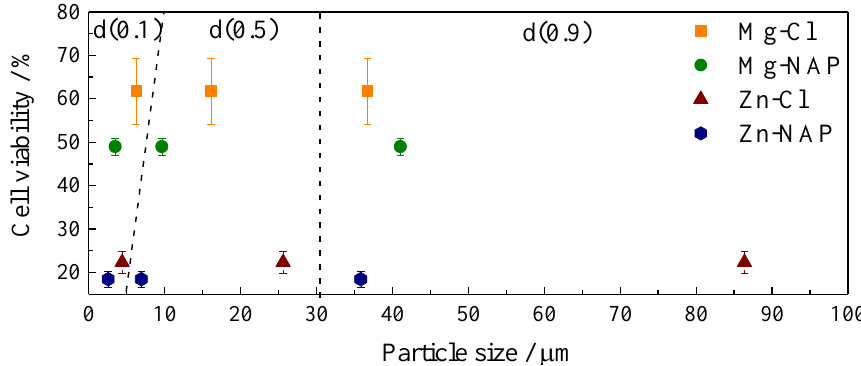
Figure 8. Cell viability percentage of LDH powder samples according to particle size expressed by d(0.1), d(0.5) and d(0.9) values (from Figure S3), related to the percentage of particles that present up to the corresponding sizes.